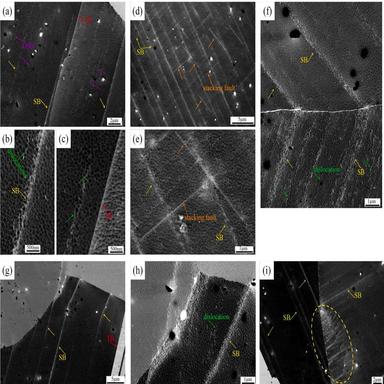
Deformation substructures in (a)–(c) region 1, (d) and (e) region 2, (f) region 3, (g) and (h) region 4, and (i) region 5 shown in (b).